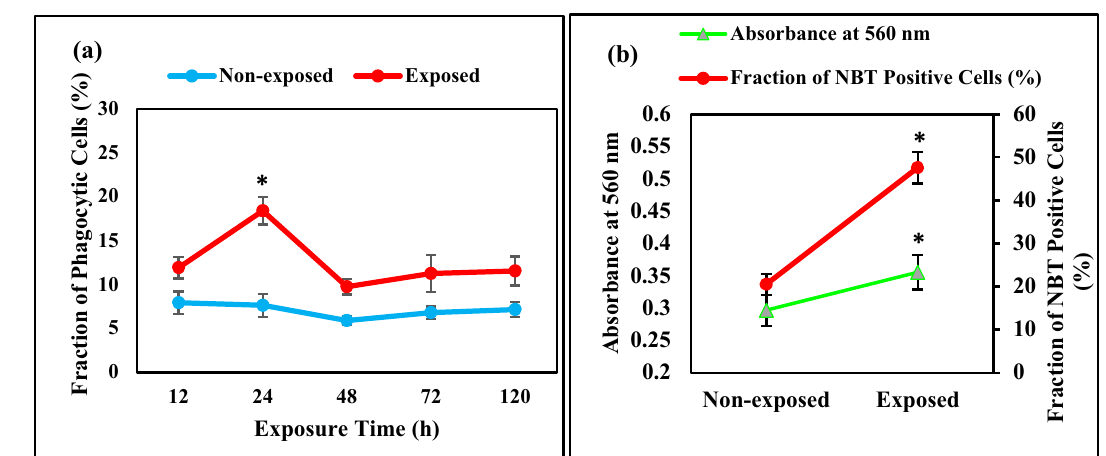
Figure 10. ELF-EMF induced differentiation of K562 cells. Histograms showing: ( a ) The Fraction of K562 cells phagocytizing latex particles in non-exposed and exposed cells of ELF-EMF with frequency 0.01 Hz and intensity 100 mT over time, ( b ) fraction of K562 cells reducing NBT in non-exposed and exposed cells of ELF- EMF (0.01 Hz, 100 mT, 24 h) and absorption of the reduced NBT (formazan) at 560 nm in non-exposed and exposed K562 cells of ELF-EMF (0.01 Hz, 100 mT, 24 h). Bars indicate means ± SEM obtained from three or more independent experiments. Statistical significance between non-exposed and exposed groups was evaluated by a t-test. ( P -value < 0.05) was considered to indicate statistical